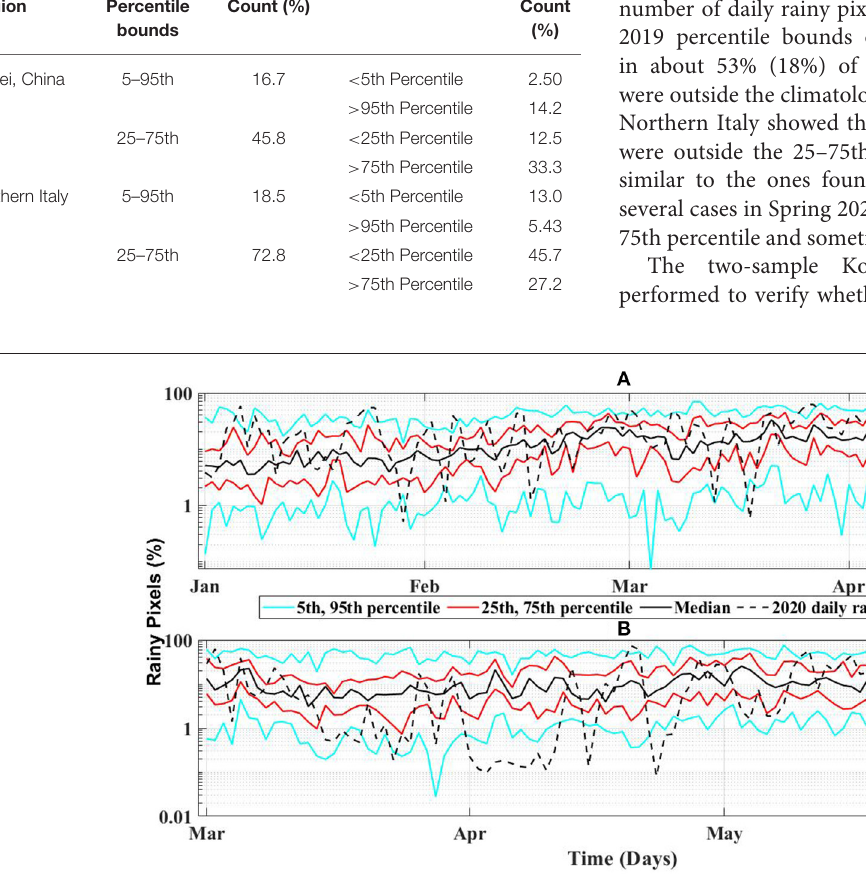
TABLE 1 | Number of times (in %) that the 2020 daily average rainfall magnitude falls outside the climatological percentile bounds. Region Percentile Count (%) Count bounds